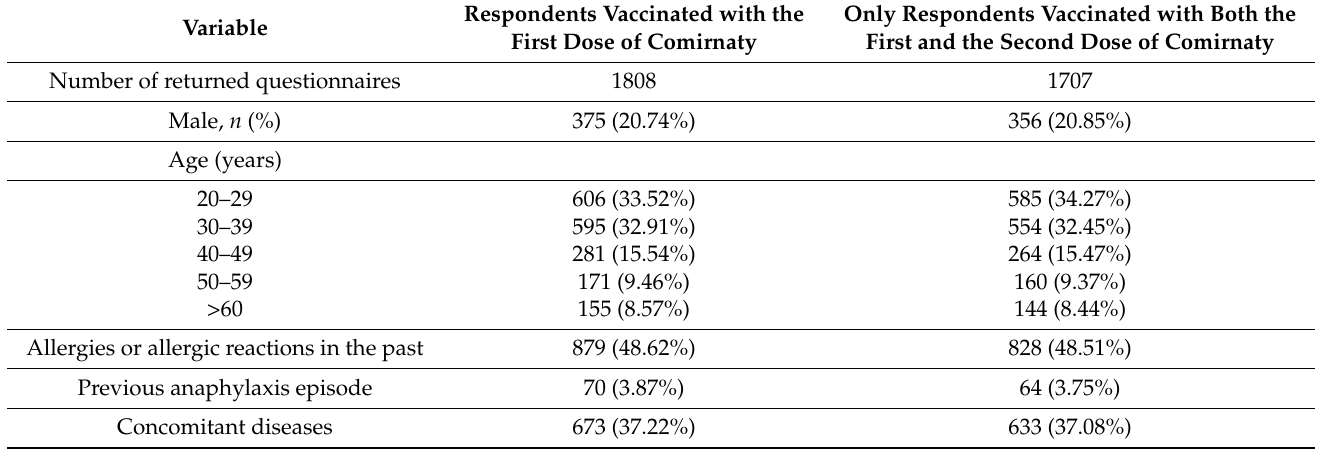
Table 1. Baseline demographic and clinical characteristics of the study group.